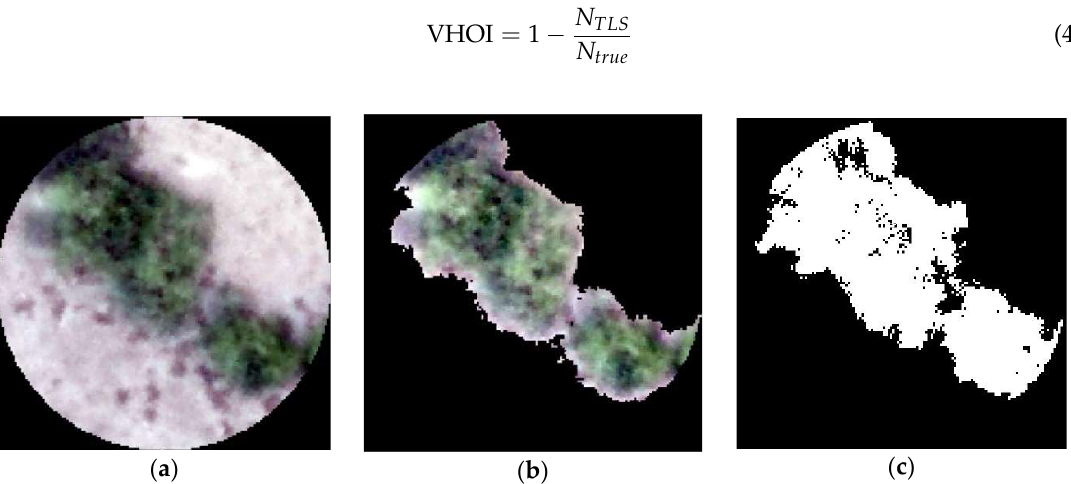
Figure 3. The calculation diagram of VHOI: ( a ) The 7 cm multispectral image (representing the real scene in this paper); ( b ) Vegetation pixels in the multispectral image, and representative the vegetation of real scene; ( c ) representing the 7 cm binary raster image obtained from binarization operation to TLS PCD (white for the vegetation). The edge length of ( a – c ) is all 10 m.